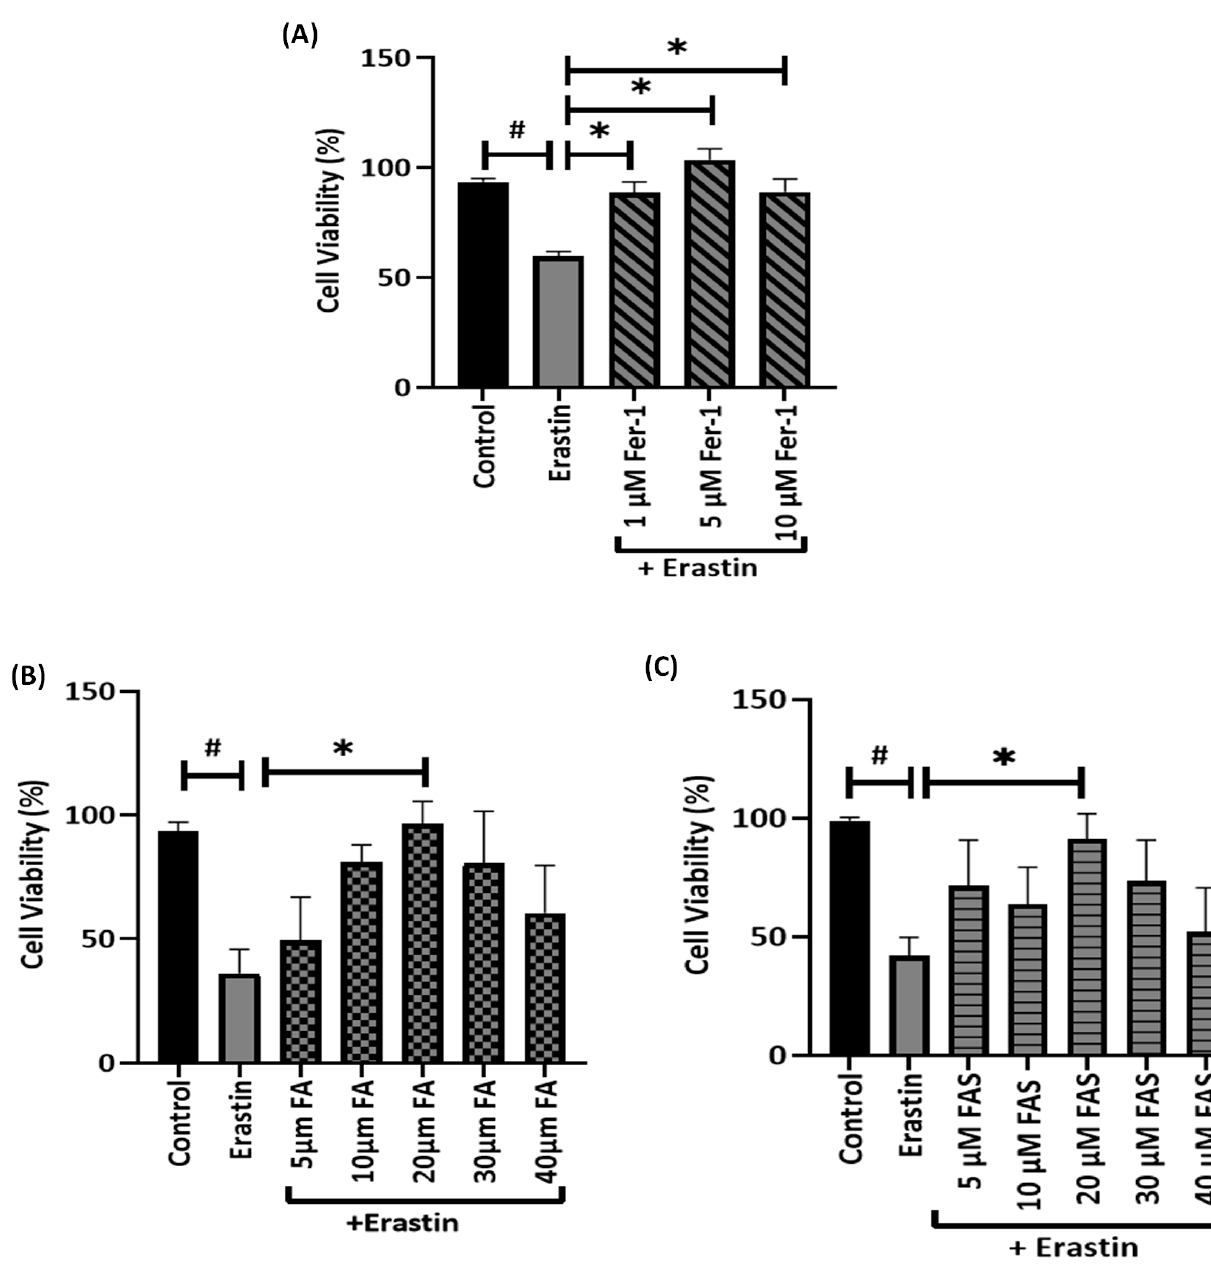
Figure 2. FA and FAS protect MIN6 cell viability from erastin-induced ferroptosis. MIN6 cells were exposed to ferroptosis inducer, 20 µ M of erastin, in the absence or presence of (1, 5, and 10 µ M) ferrostatin (Fer-1) ( A ), (5, 10, 20, 30, and 40 µ M) ferulic acid (FA) ( B ), or (5, 10, 20, 30, and 40 µ M) ferulic acid 4-O-sulfate disodium salt (FAS) ( C ) in a dose-dependent manner for 24 h. Cell viability was assayed to show the protective effects of FA, FAS, or Fer-1 against erastin treatment. All the values are expressed as the mean ± SEM, n = 8. # p < 0.05 control vs. treatment groups; * p < 0.05 erastin vs. treatment groups. One-way ANOVA, Tukey’s post hoc test. To examine whether FA and FAS might protect MIN6 cells from ferroptosis, pancreatic MIN6 cells were treated with 20 µ M of erastin. Intracellular ROS levels were detected in erastin-treated MIN6 cells by measuring 2 (cid:48) ,7 (cid:48) –dichlorofluorescein (DCF) by flow cytometry. Compared with the control group, the intracellular ROS levels of MIN6 cells were